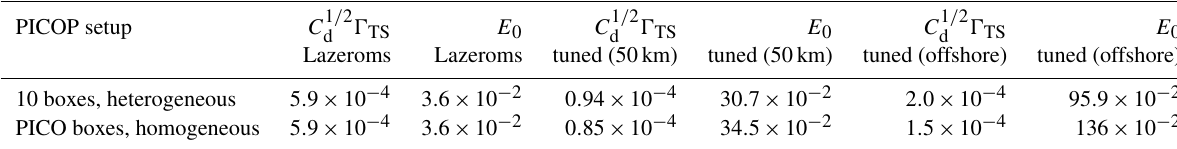
Table 10. Comparison between original and best-estimate parameters tuned over the full 35 ice shelves and 127 years for the PICOP parameterisation. These are the plume parameters; the box parameters are the tuned parameters, for the 10-box and PICO boxes respectively, shown in Table